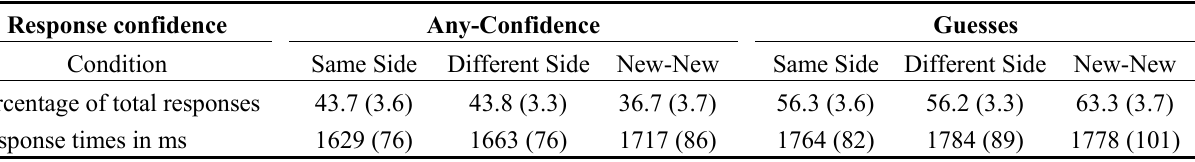
Table 1. Summary of response data for each presentation condition, showing mean percentage of total responses across the two confidence categories, and response